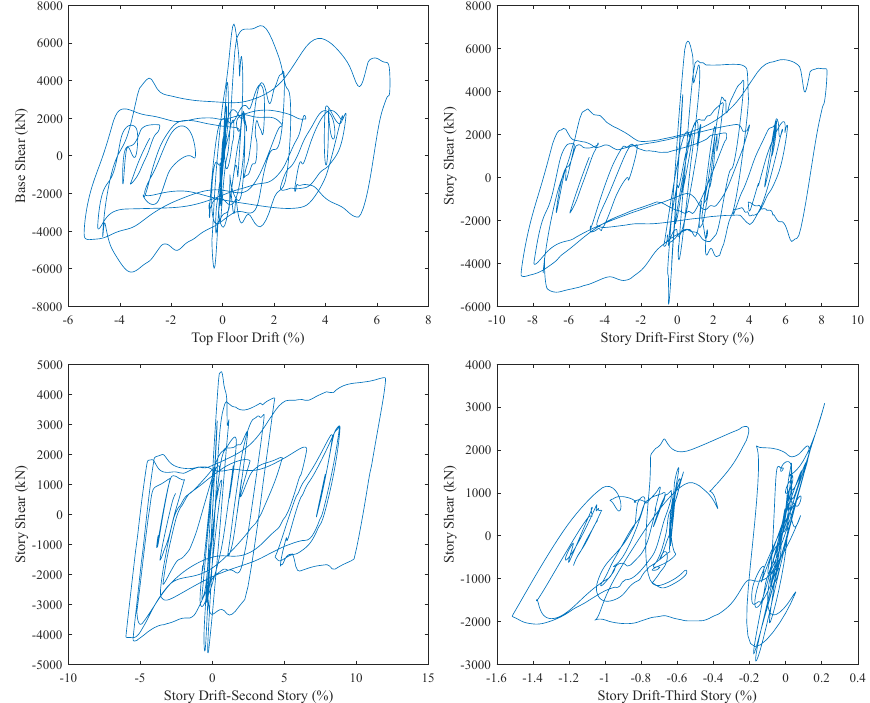
Figure 9. Hysteretic behavior of the chevron-braced